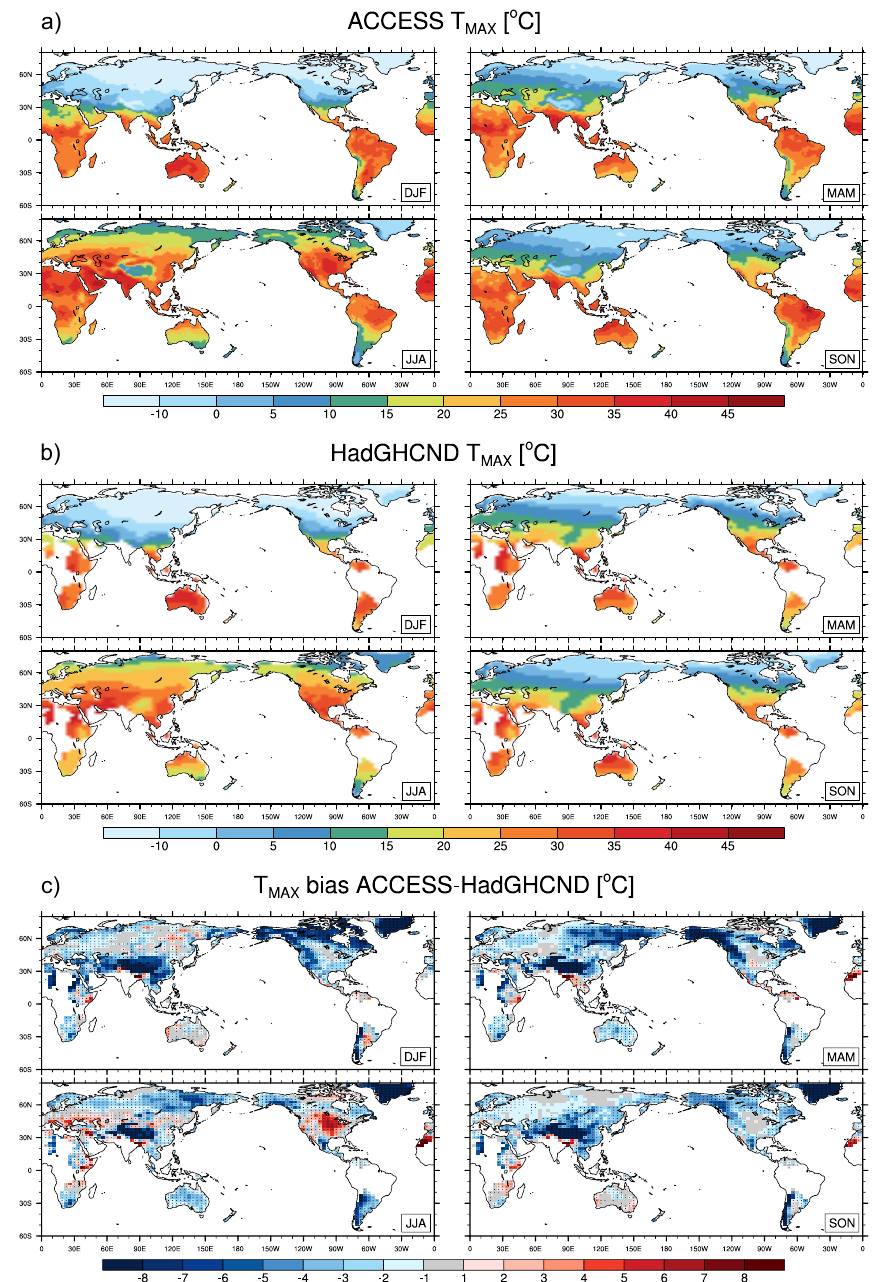
Fig. 1. Daily T MAX for ACCESS1.3b (a) , HadGHCND (b) and bias (c) . Unshaded areas in (b) and (c) reflect missing observation data. The considered time period is the overlapping time period between model run and observations, 1951–2011. Stippling in (c) indicates areas where bias is statistically significant based on the modified t